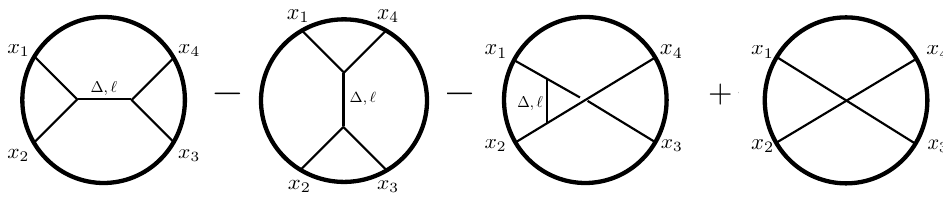
Figure 1 . The Polyakov block P + , ∆ ,‘ is a crossing antisymmetric combination of Witten exchange diagrams W ∆ ,‘ ( u, v ) (with odd spin ‘ ) and antisymmetric ‘contact’ diagrams’ C + ( u, v )